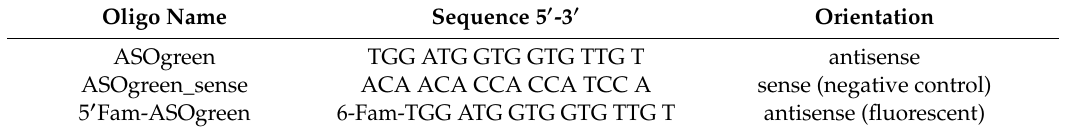
Table 1. α -epithelial sodium channel (ENaC) antisense oligonucleotides. Oligo Name